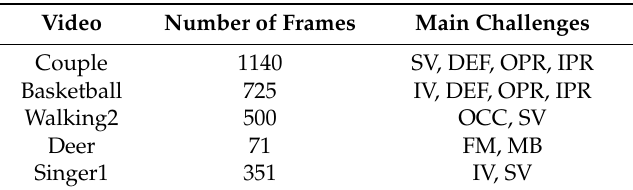
Table 2. Experimental